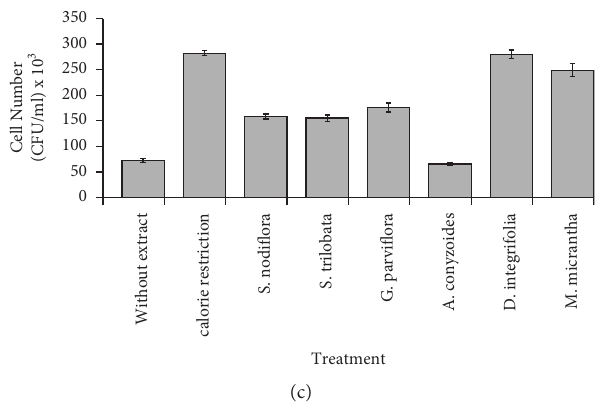
Figure 3: Effect of (a) water fraction, (b) chloroform fraction, and (c) water extract on the cell number of stationary phase-yeast cells (11 days of treatment incubation). Yeast cells were grown in YES medium containing an optimum concentration of plant extract/fractions as observed previously in oxidative stress tolerance assay. Yeast cells grown in EMM medium supplemented with DMSO were designated as calorie restriction for the positive control treatment, while yeast cells grown in YES medium supplemented with DMSO only without any extract/fractions addition were used as control. Each culture treatment was then incubated for 11 days and enumerated for cell con- centration based on plate count assay using YES agar. Plates were incubated for three days at 30 °